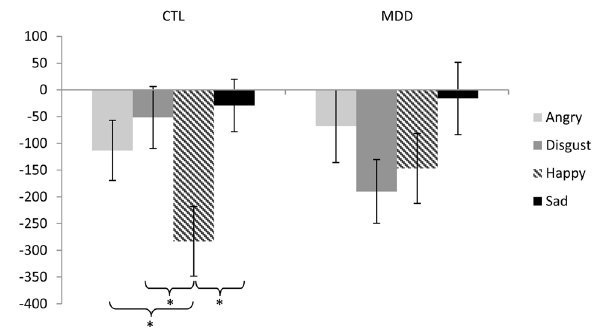
FIGURE 1 | Priming scores for each emotion (angry, disgust, happy, and sad) for both control (CTL) and depressed (MDD) participants. Negative priming scores reflect reverse priming or difficulty disengaging from the emotional compared to neutral primes. Error bars indicate ± 1 SE. ∗ p < 0 .